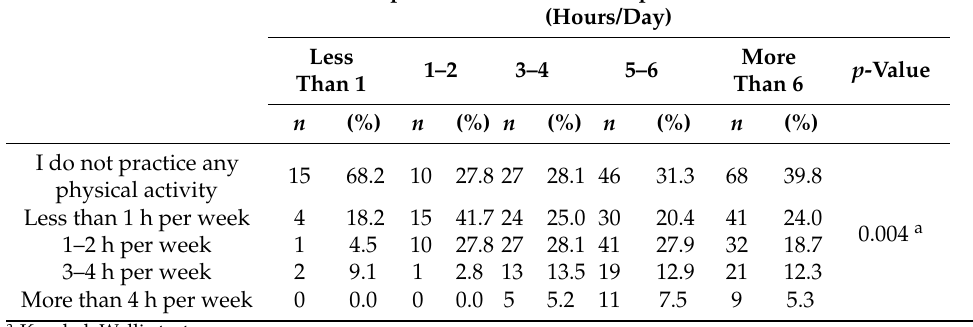
Table 8. Comparison of the physical activity (PA) and the hours spent in front of the computer/mobile devices/TV during the full COVID-19 curfew period.